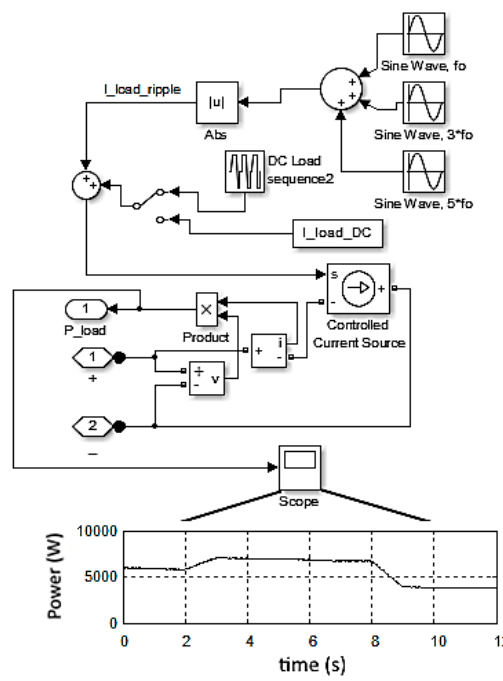
Figure 4. The diagram of the equivalent load.